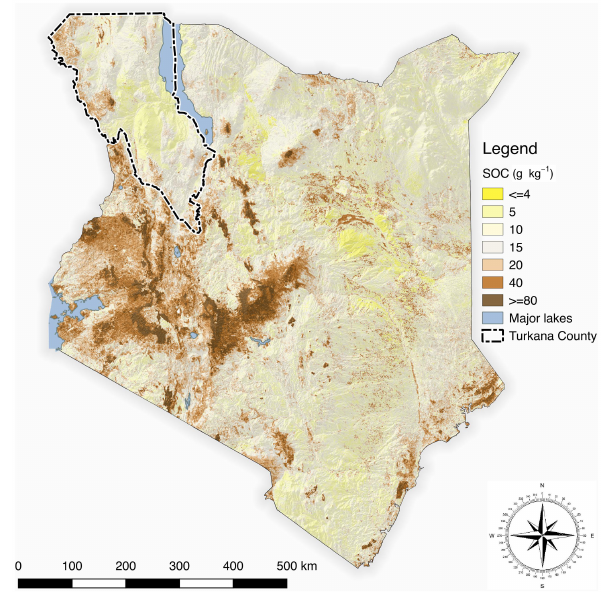
Figure 2. Soil organic carbon (SOC) map of Kenya at 500m res- olution (for 2012). Turkana County is located in the northwestern corner of the country, and is outlined on the map.